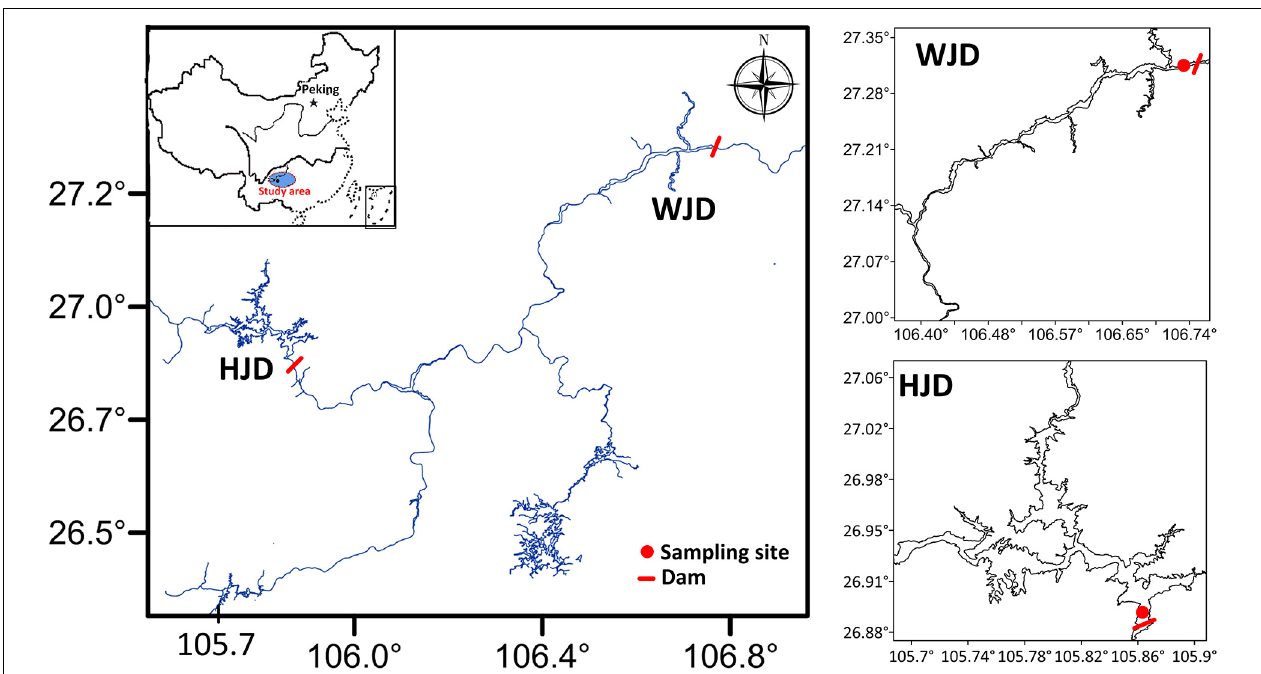
FIGURE 1 | Sampling sites and locations of the Hongjiadu (HJD) and Wujiangdu (WJD) reservoirs along the Wujiang River,